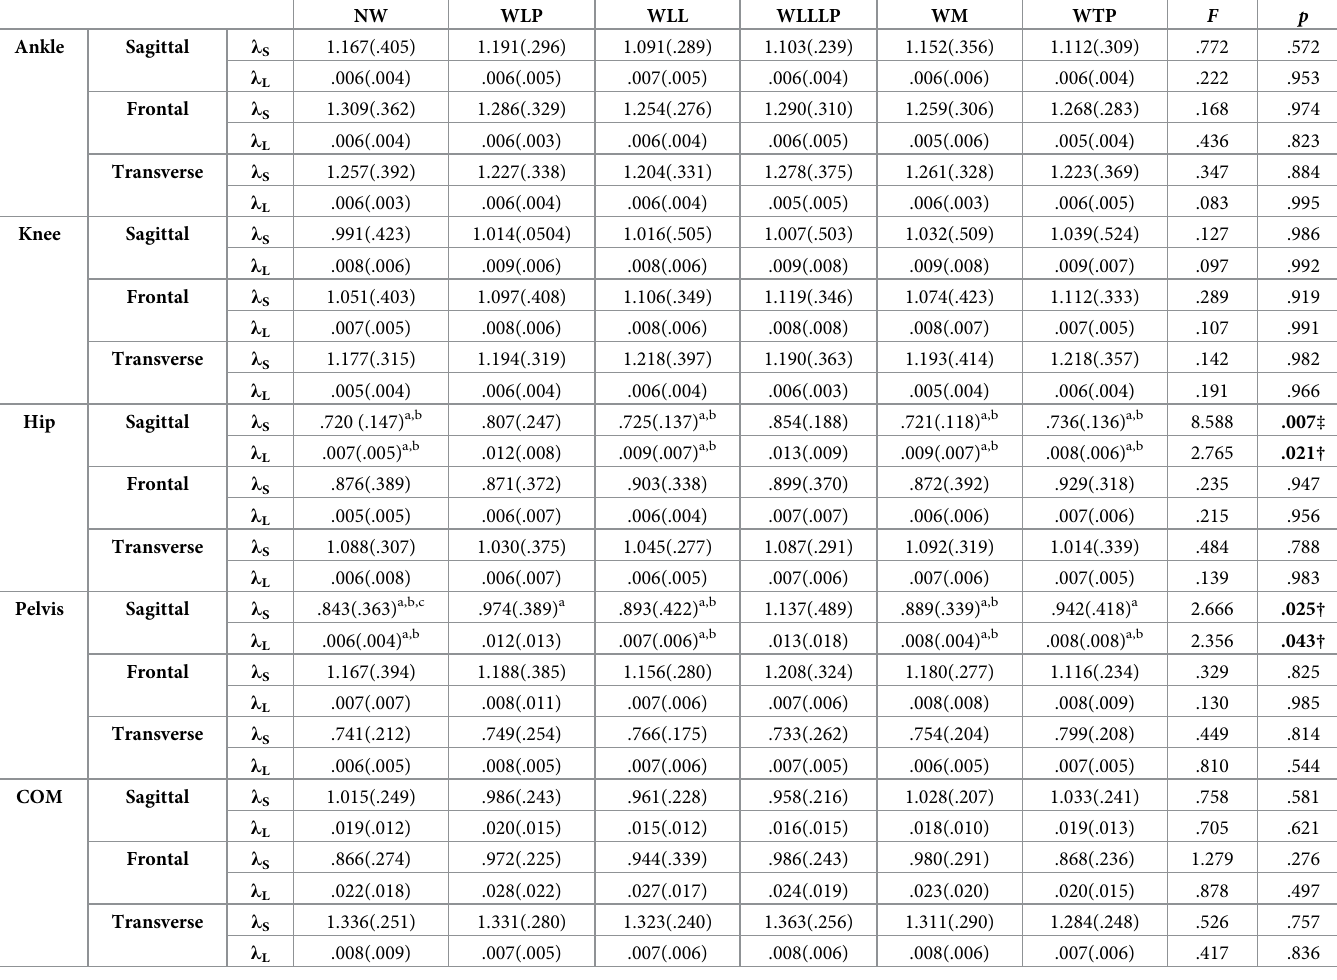
Table 1. Descriptive measures of λ S and λ L for the ankle, knee, hip and pelvis angles, and the COM and their differences in various walking conditions in sagittal, frontal and horizontal